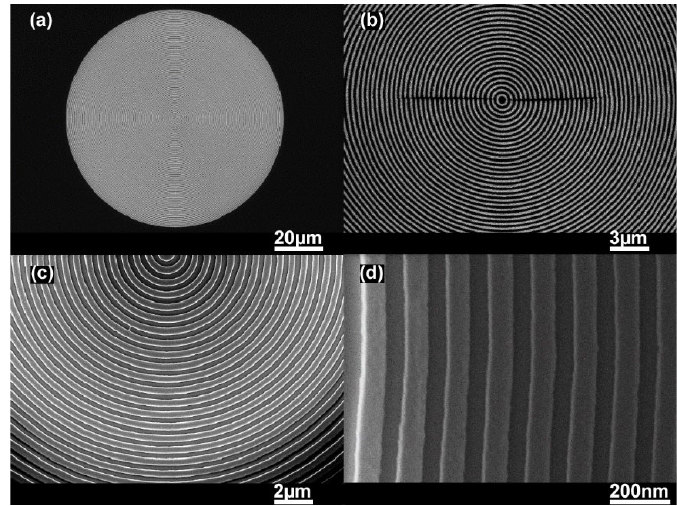
Figure 2. Scanning electron microscopic (SEM) images of the circular periodic nanostructures at ( a ) 1.03 k×, ( b ) 6.74 k×, ( c ) 12.29 k×, and ( d ) 42.08 k× magnifications, respectively, showing the well-defined morphology of the respective ring cavities.